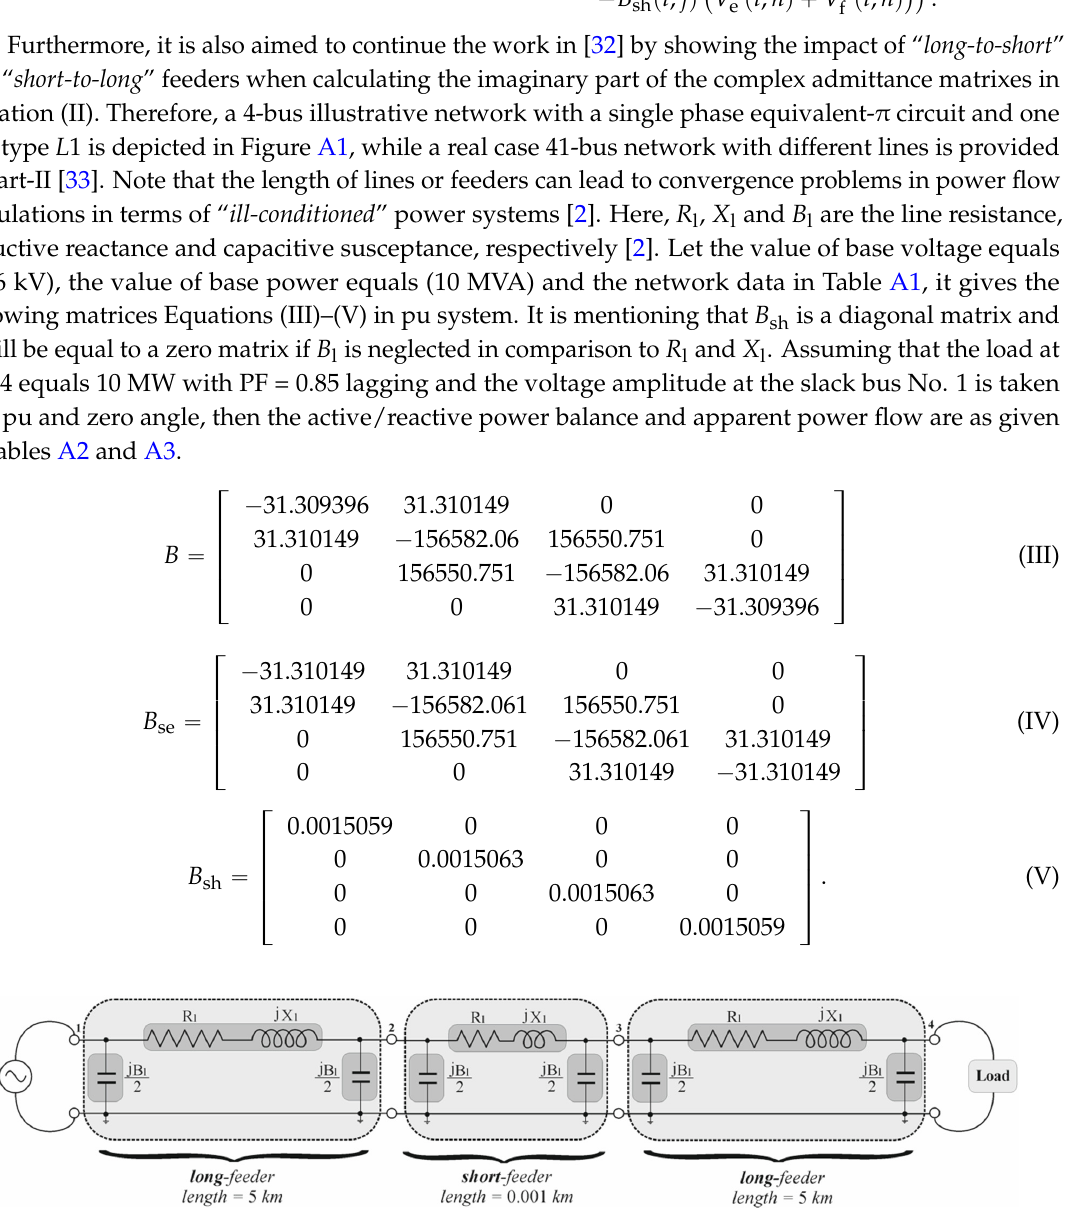
Table A2. Active and reactive power balance in the 4 ‐ bus network. P d (MW)